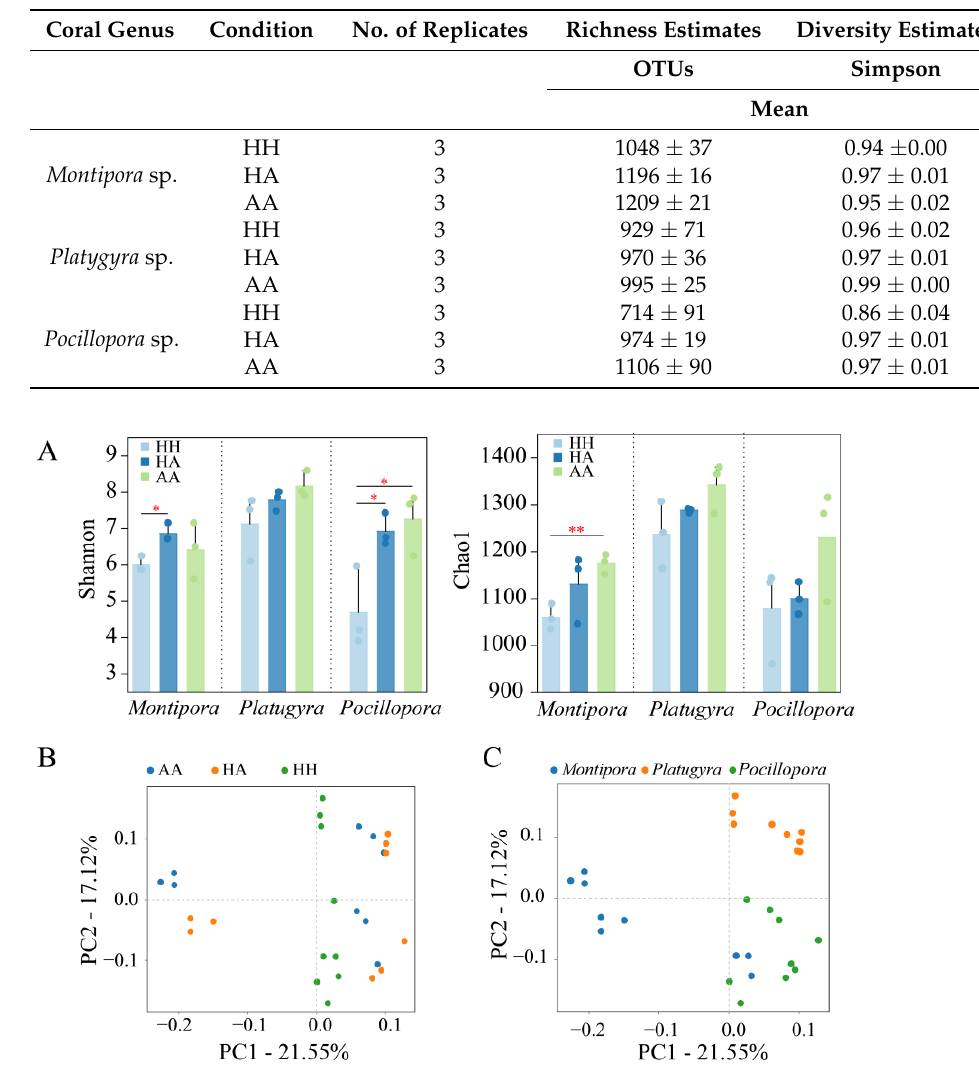
Figure 2. Alpha diversity and beta diversity of three coral genera: ( A ) Shannon index and Chao1 index; p < 0.05 and p < 0.01 are marked with “*” and “**”, respectively. Unweighted Unifrac PCoA blot showing the differences between bacterial communities based on OTUs among coral health status ( B ) and coral genera ( C ).